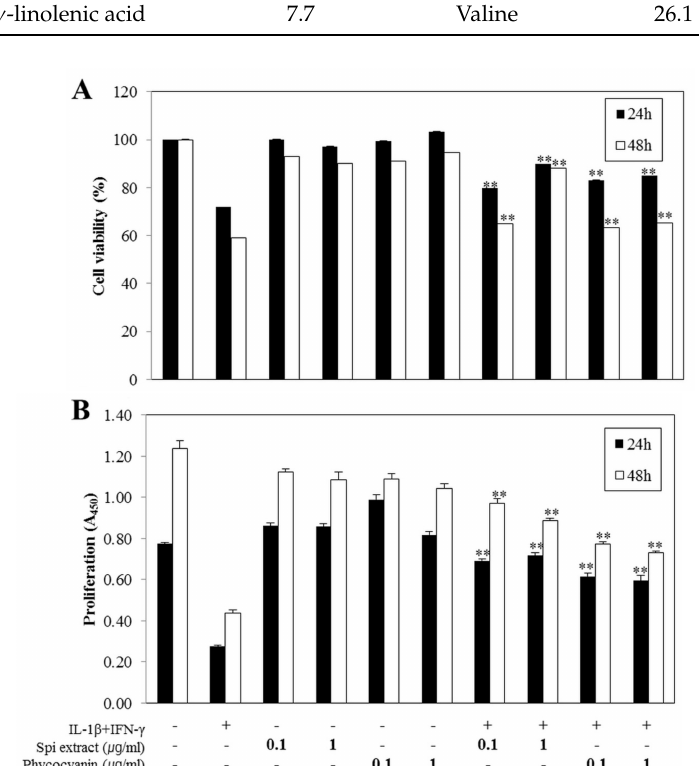
Figure 2. Spirulina extract protects against IL-1 β - and IFN- γ -induced cell death. ( A ) Cell viability and ( B ) proliferation determined by the XTT assay and BrdU incorporation assay, respectively. The cells were co-treated with or without IL-1 β (50 U/mL), IFN- γ (100 U/mL), and Spirulina (Spi) extract or PC (100 ng, 1 µ g/mL) for 24 and 48 h. Each value represents the mean ± SEM of three independent experiments. The two-sample t -test was used to compare the results between the control group and treatment group. ** p < 0.01, significant difference between the Cytokine-treated and Cytokine + Spi extract or Cytokine + PC